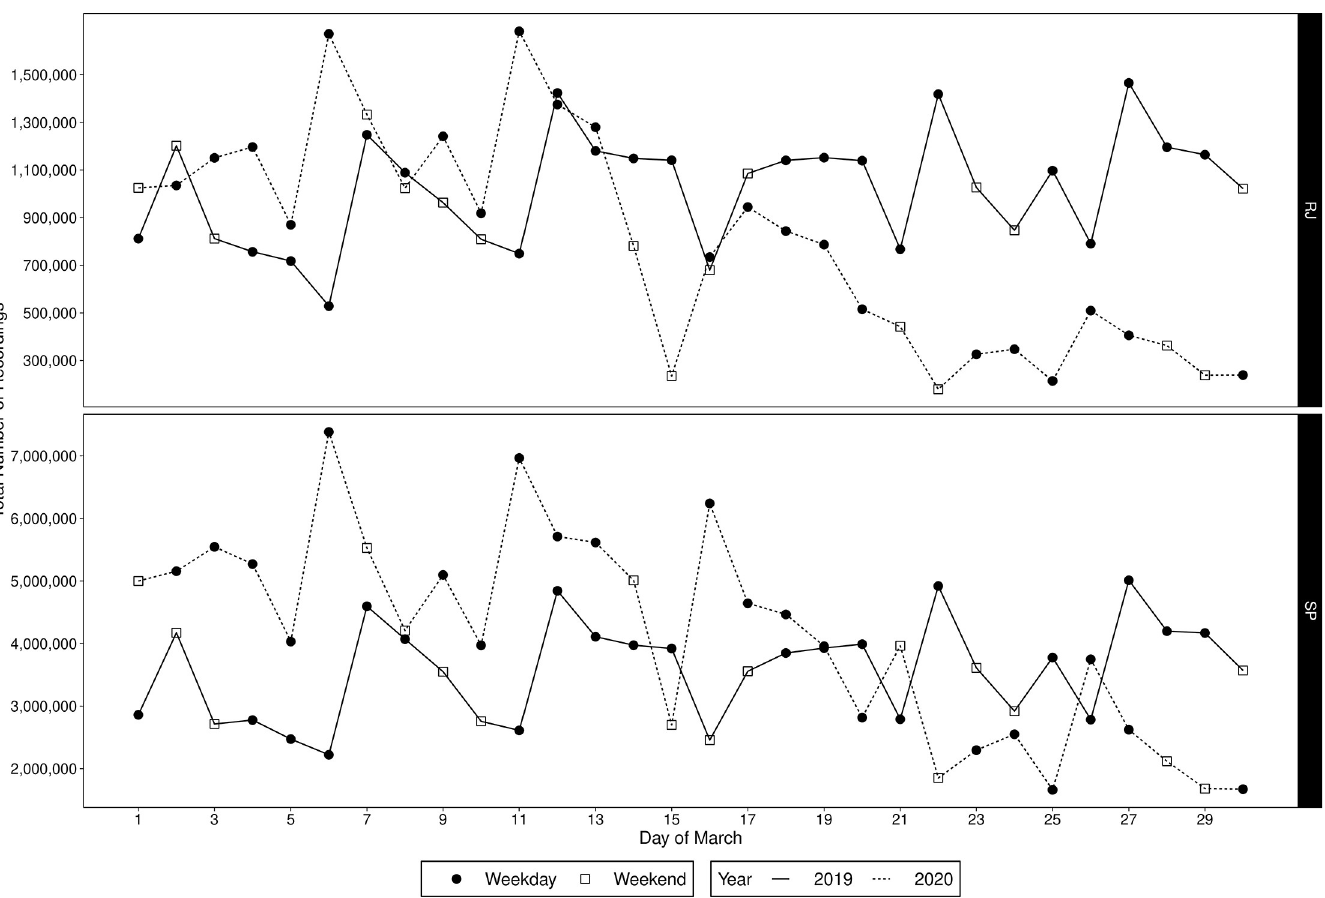
Fig 1. Total number of recordings for each day of March in S ã o Paulo (SP) and Rio de Janeiro (RJ), in 2019 and 2020.